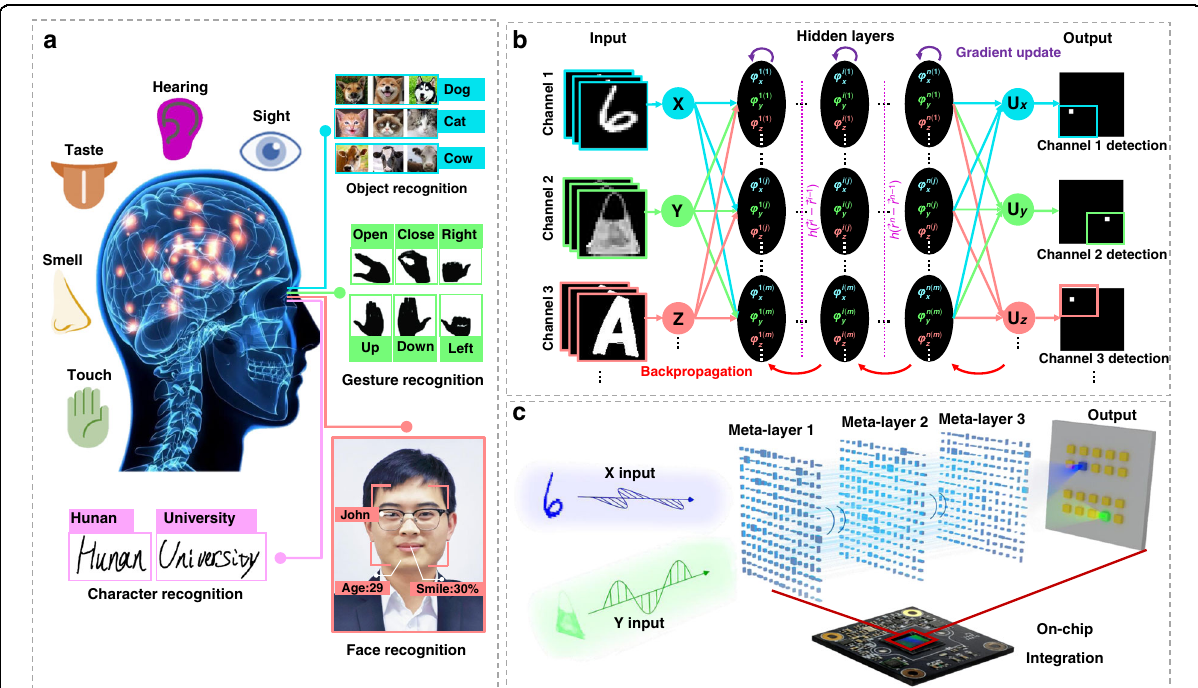
Fig. 1 Multiplexed human brain perception system and schematic of multiplexed metasurface-based diffractive neural networks (MDNN) integrated on an imaging sensor chip. a Multi-channel senses of the human brain mainly comprise sight, hearing, smell, taste, and touch, among which vision can be subdivided into object recognition, gesture recognition, character recognition and face recognition, etc. b Architecture of the MDNN. The meta-neurons of the multiple networks are trained individually to obtain multiplexed phase distributions, which are optimized by an error backpropagation algorithm running in computer. c Optical layout of polarization-dependent object classi fi cation for the MDNN concept. The input is the light carrying information about the object to be recognized, e.g., a handwritten digit or a fashion product in x - and y -polarization, respectively. The hidden layers consist of polarization-multiplexed metasurfaces acting as neurons, and subsequently converge the diffraction energy to the corresponding photoelectric detection region on the CMOS chip (i.e., the output layer of